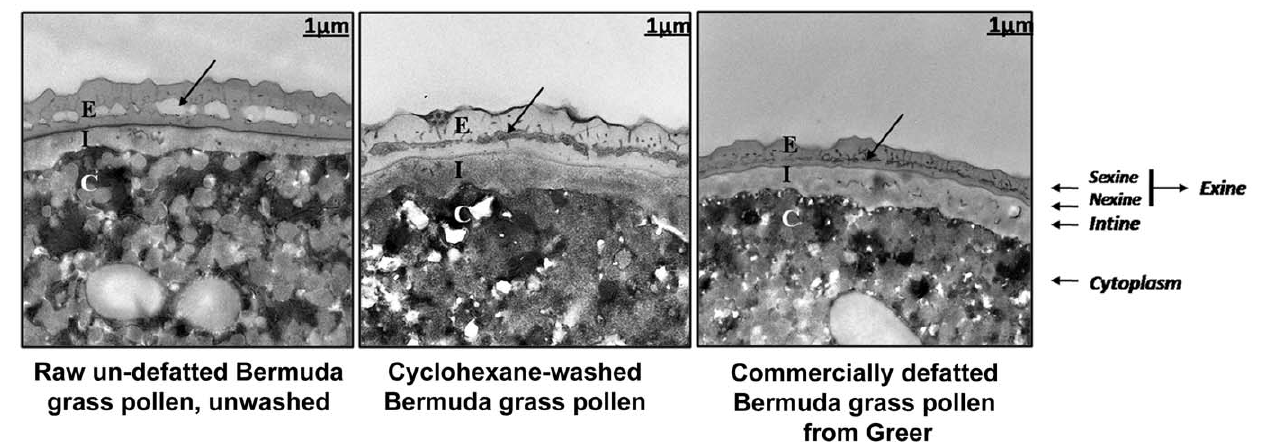
Figure 1. Transmission electron micrographs (TEMs) of BGP after extraction with organic solvents. The microchannels of the raw un- defatted pollen grain are covered with electron-dense surface coat materials, whereas in defatted pollen the microchannels of the surface coat are almost empty of electron-dense material. The microchannels of the exine layer, indicated by arrows, appear to collapse after organic-solvent extraction. The close proximity of the exines’ dark-staining inner channel surfaces makes the collapsed channels of the washed pollen darker than those of the raw un-defatted pollen. The supplier washes un-defatted pollen with n-Hexane to produce commercially defatted pollen. E, exine; I, intine; C, cytoplasm.